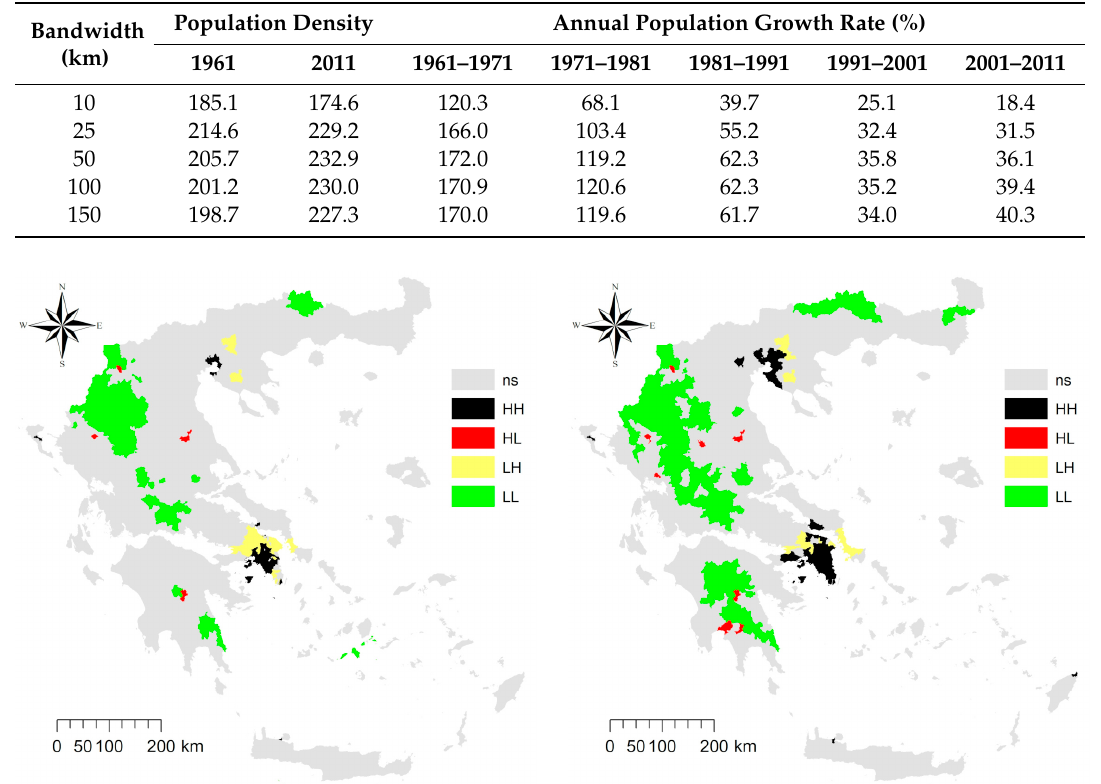
Table 2. Global Moran’s spatial autocorrelation coe ffi cients for demographic density (1961 and 2011)